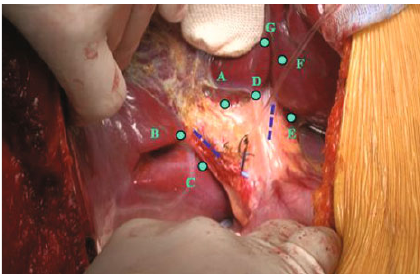
Figure 2: Hepatic pedicle and the site of dissecting for selective Glissonean pedicle control [13, 14].